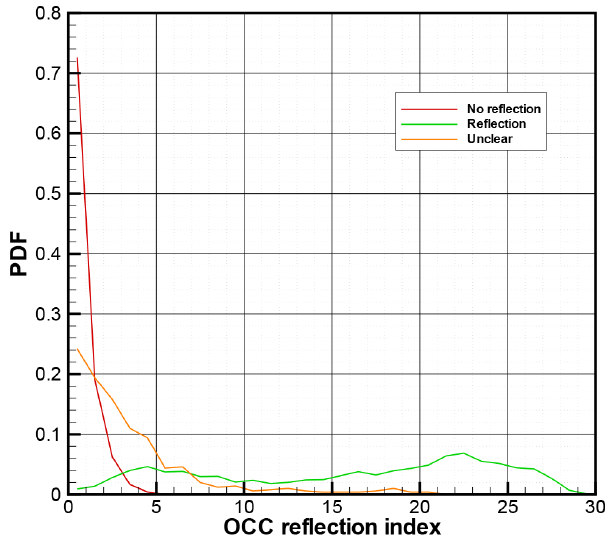
Figure 14. Probability distribution function of I R for the three cat- egories of